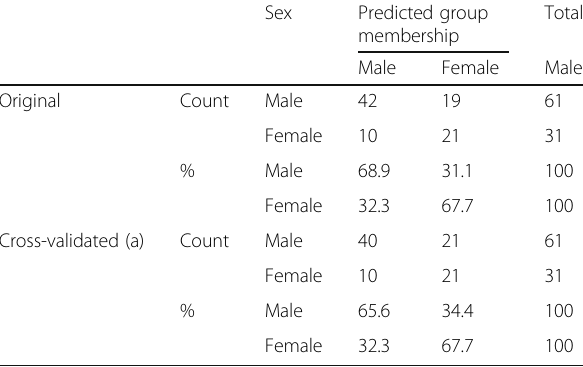
Table 6 The summary of classification